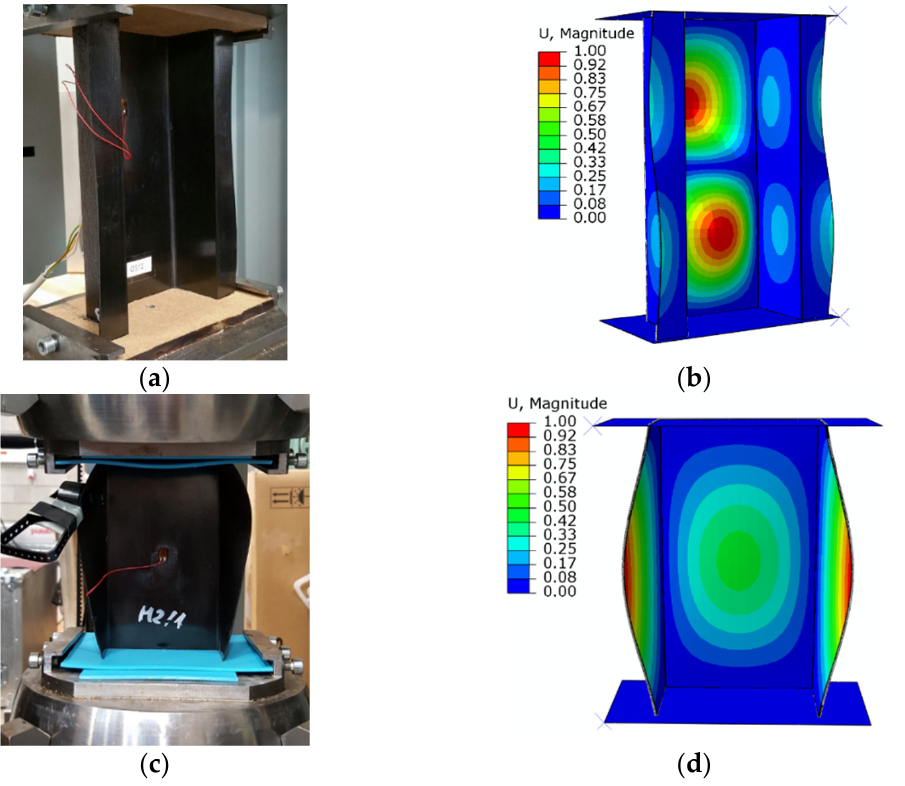
Figure 4. Buckling results: ( a ) EXP of top-hat profile, ( b ) FEM of top-hat profile, ( c ) EXP of channel profile, ( d ) FEM of channel profile.